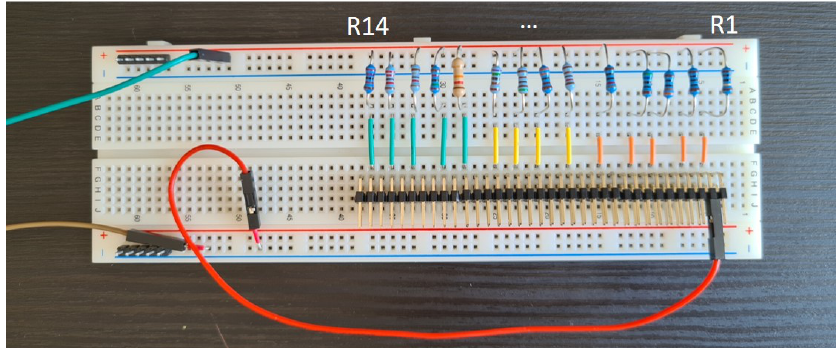
Figure 5. PCB picture of ( a ) one-stage multiplier and ( b ) two-stage multiplier.